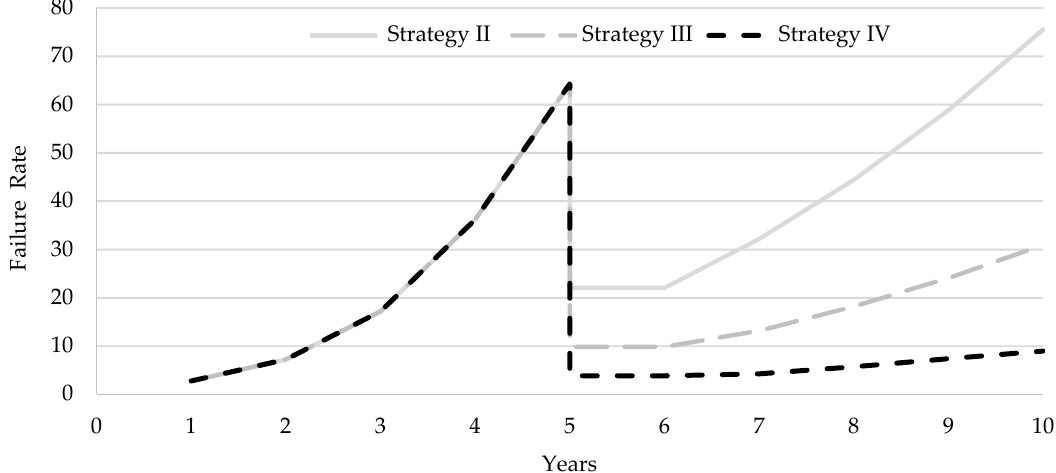
Figure 7. E ff ect of two kinds of overhaul strategies along the planning horizon. Figure 7. Effect of two kinds of overhaul strategies along the planning horizon.